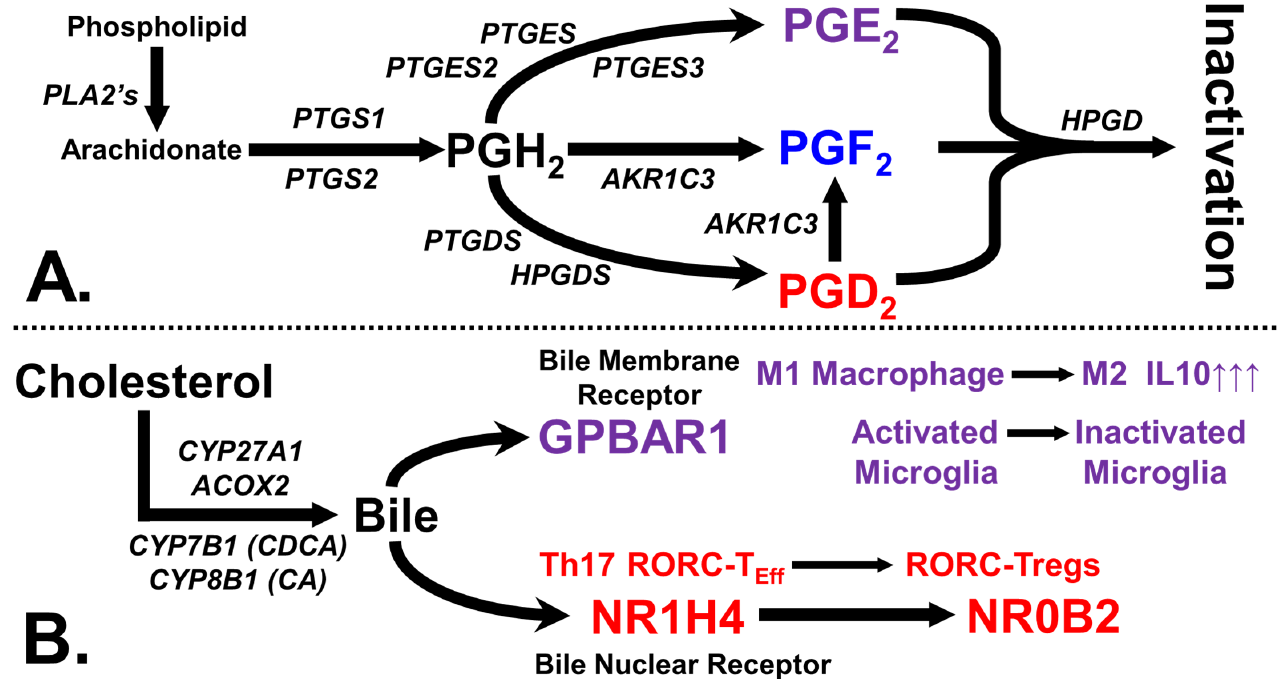
Figure 1. Enzymes and receptors used for prostaglandin/bile salt synthesis and signaling. ( A )